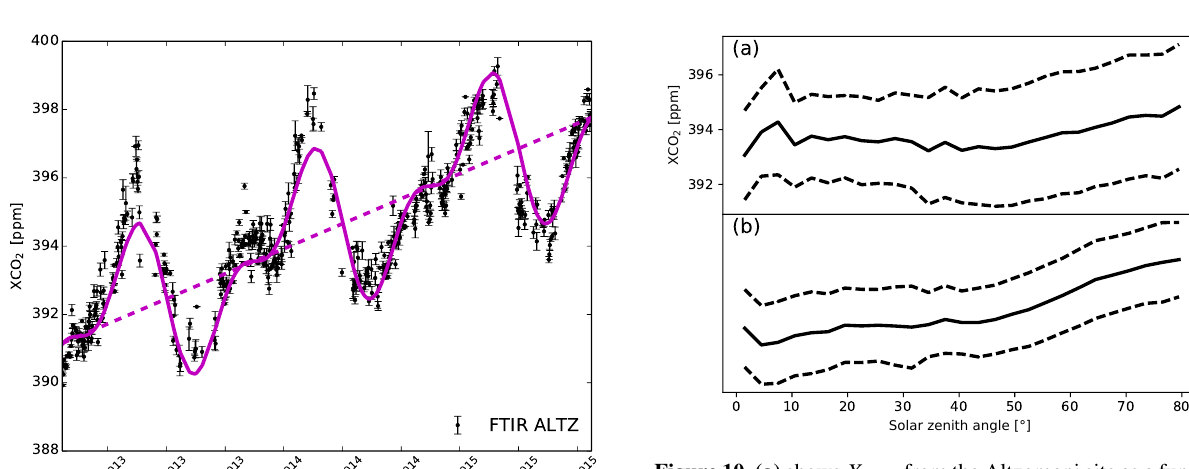
Figure 10. (a) shows X CO from the Altzomoni site as a function of 2 solar zenith angle. (b) shows the seasonally detrended X CO using 2 the coefficients obtained for Eq. (5). The solid lines represent mean data set from the Altzomoni 2 values and the dashed lines standard